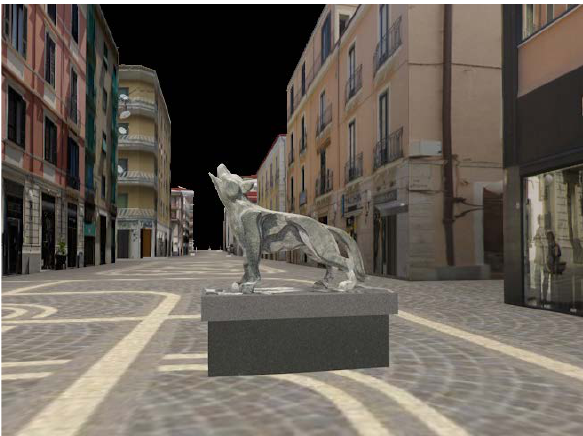
Figure 8. The Wolf of Sila in the present location.